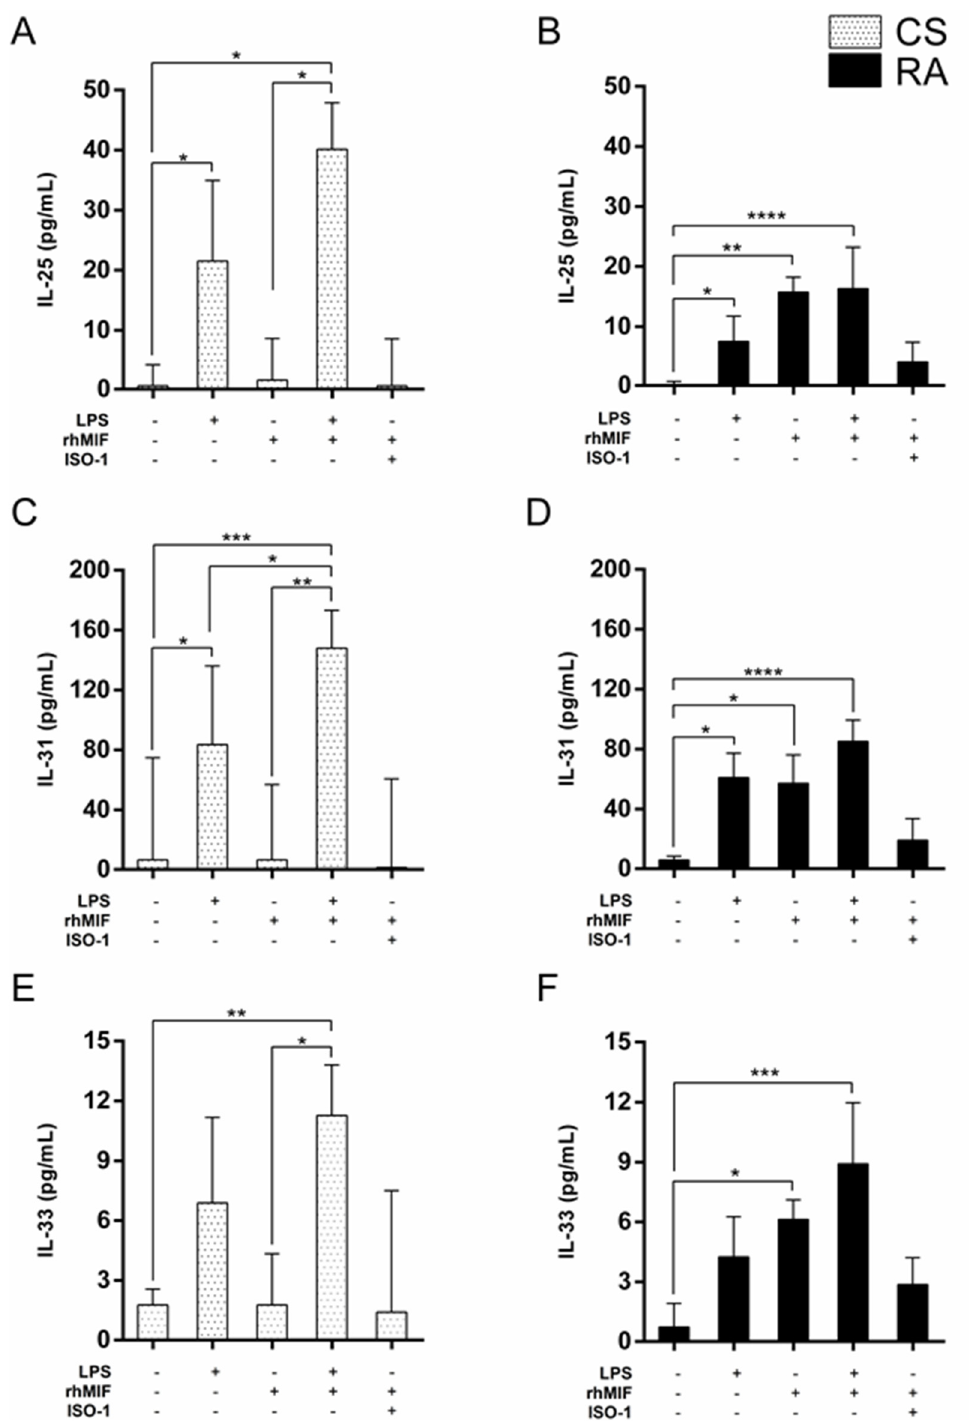
Figure 1. Levels of IL-25, IL-31, and IL-33 in supernatants of PBMC from CS (white with black dots) and RA patients (black) after 24 h of stimulation with LPS, rhMIF, and ISO-1 in different combinations. The soluble levels of IL-25 ( A , B ), IL-31 ( C , D ), and IL-33 ( E , F ) in the supernatant of unstimulated PBMC and stimulated PBMC with LPS (30 ng/mL), rhMIF (200 ng/mL), LPS (30 ng/mL) plus rhMIF (200 ng/mL), and rhMIF (200 ng/mL) plus ISO-1 (100 µM) were determined. The plus and minus signs (+ and − ), represent the presence and absence of the reagent mentioned at the bottom of each graph, respectively. All assays were set up in triplicate ( n = 18 per group). Data provided in median and interquartile range 25th–75th. Statistical analysis was performed using the Kruskal–Wallis test followed by Dunn’s multiple comparison test. In all Kruskal–Wallis tests, p < 0.05 was obtained. * p < 0.05, ** p < 0.01, *** p < 0.001, **** p < 0.0001.